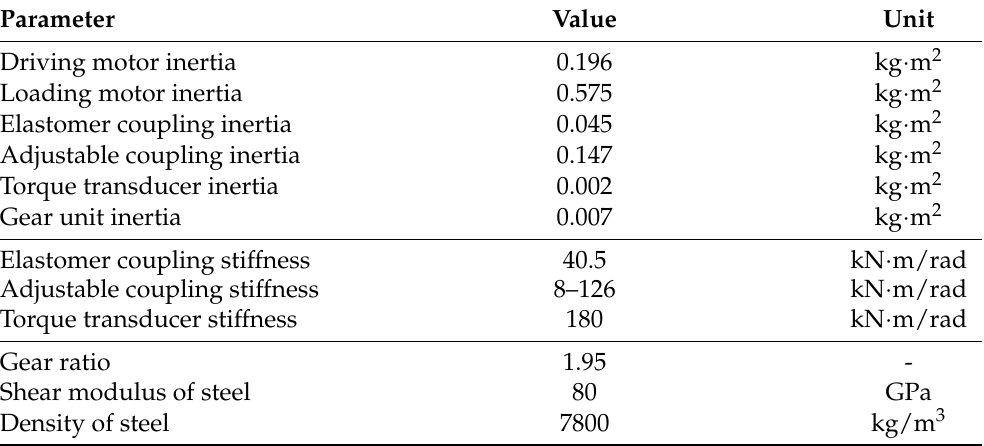
Figure 3. Dimensions of the test rotor. 3. Shaft end flange, 4. Torque transducer, 5. Test rotor, 6. Shaft end flange. Table 2. Parameters used in the finite element